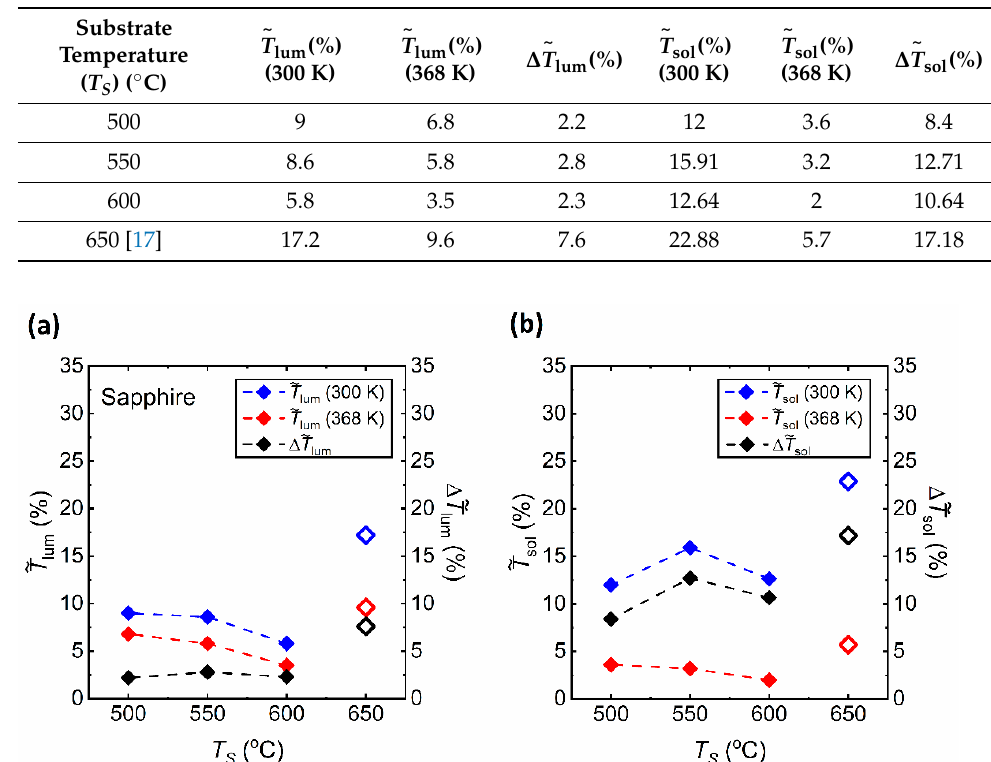
Figure 9. ( a ) Luminous transmittance ( (cid:101) T lum ) at 300 K and 368 K and luminous modulation efficiency ( ∆ (cid:101) T lum ) obtained for films deposited at various substrates temperatures ( T S ). ( b ) Solar transmittance ( (cid:101) T sol ) at 300 K and 368 K and solar modulation efficiency ( ∆ (cid:101) T sol ) obtained for films deposited at various substrates temperatures ( T S ). Data for the substrate temperature ( T S ) of 650 ◦ C [17] are presented in hollow symbols. Table 4. Luminous and solar modulation efficiencies of VO 2 films prepared on sapphire substrates at various T S .